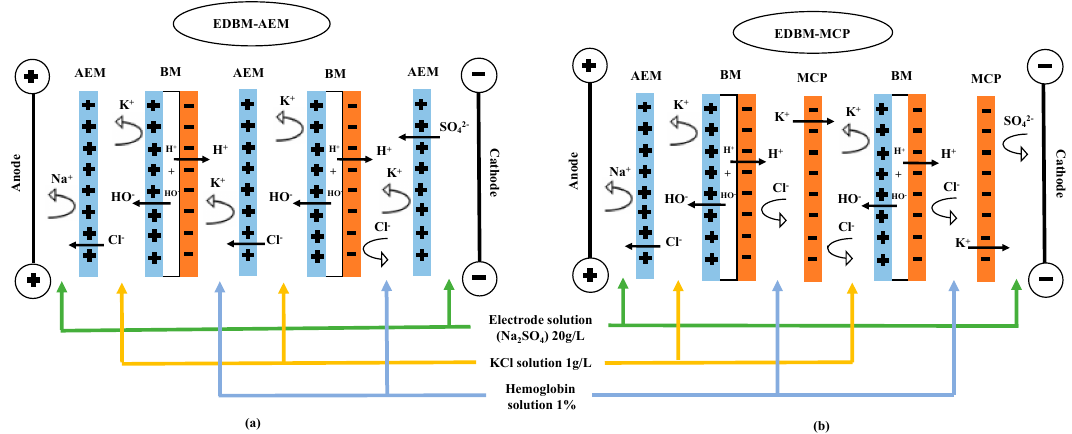
Figure 1. Schematic representation of electrodialysis cell configurations used for electro-acidification and hydrolysis of bovine hemoglobin in ( a ) electrodialysis with bipolar and anion exchange membranes (EDBM-AEM) and ( b ) electrodialysis with bipolar and monovalent cation permselective membranes (EDBM-MCP). MCP: monovalent cation permselective membrane; AEM: anion exchange membrane; BM: bipolar membrane.